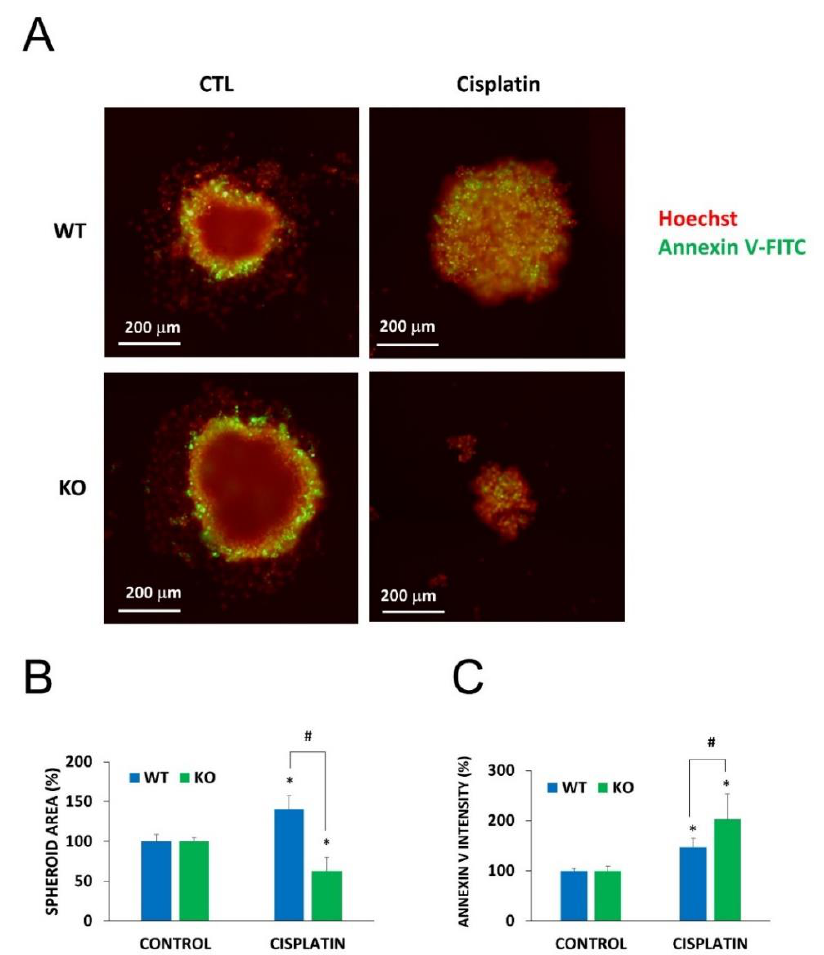
Figure 6. Chemosensitivity of spheroids to cisplatin treatment. Using WT and NMNAT-1 − / − U-2OS cells, 3D cell cultures (spheroids) were generated. Spheroids were treated with cisplatin (50 µ g / mL) for 6 days. Cells were stained without fixation with Hoechst (red pseudocolor) and Annexin V (green). Representative images are shown in panel A . Images of 3 spheroids / treatment were taken and analyzed for area ( B ) and the intensity of the inner region ( C ). Results are expressed as percentages of the control (vehicle treated) samples. Bars marked with asterisks are significantly di ff erent from the vehicle treated control (Student-Newman-Keuls method; * p < 0.05). Bars marked with hashmarks are significantly di ff erent from the cisplatin treated wild type spheroids (Student-Newman-Keuls method; # p < 0.05). Data plotted are means ± SEM ( n = 3).